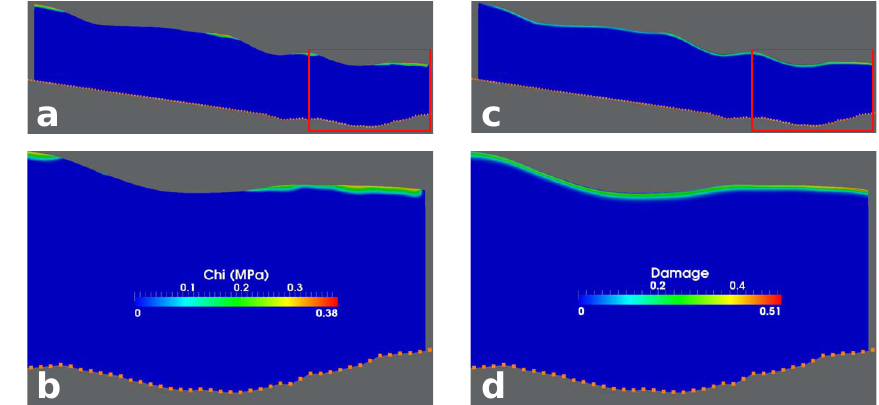
Figure 8. State of Helheim Glacier after 365 days of simulation for the set of parameter ( σ th = 0.11MPa, B = 1.30MPa − 1 , and D c = 0.50) corresponding to the red star in Fig. 7. χ is the damage criterion, which is positive where damage will occur. (a) Damaging areas of Helheim Glacier and (b) close-up of the red rectangle; (c) damage field and close-up of the red rectangle (d) .